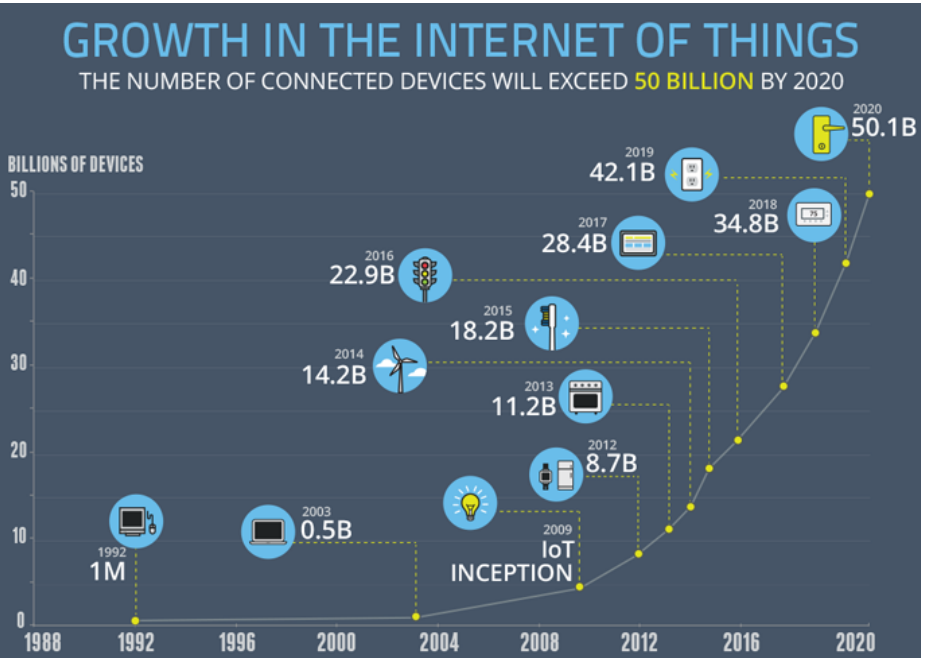
Figure 1. The population growth of the Internet of Things